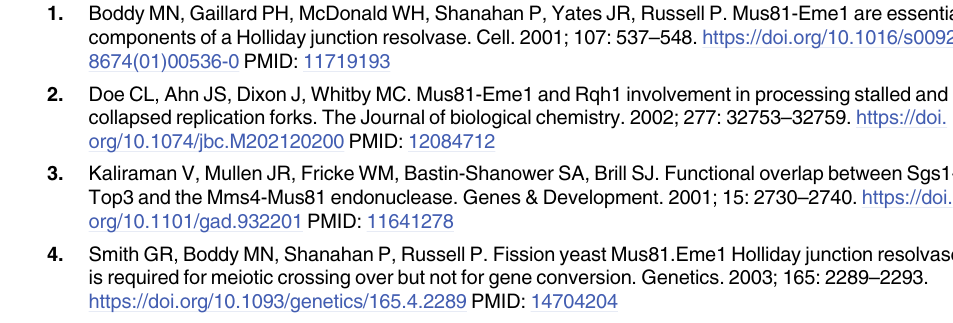
S1 Table. Complete list of S. pombe strains used in this